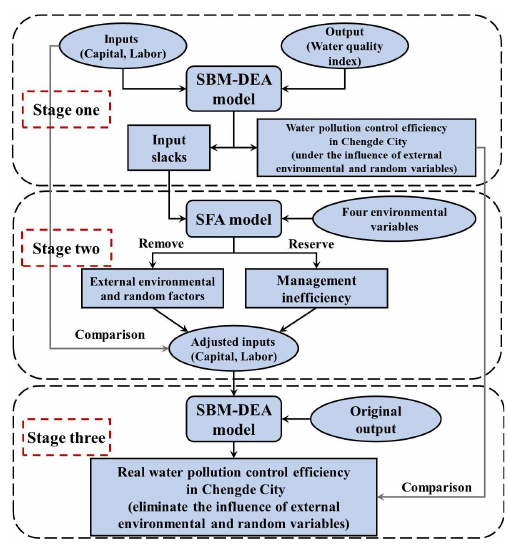
Figure 1. The analytical framework.